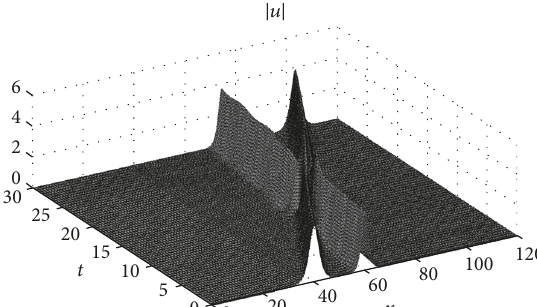
Figure20:Viewinthe 𝑥 - 𝑡 planeofthecollisionoftwosolitarywaves of the SBO system with velocities 𝑐 = 0.5 and 𝑐 = 2 . Observe that the colliding waves have different initial amplitude.